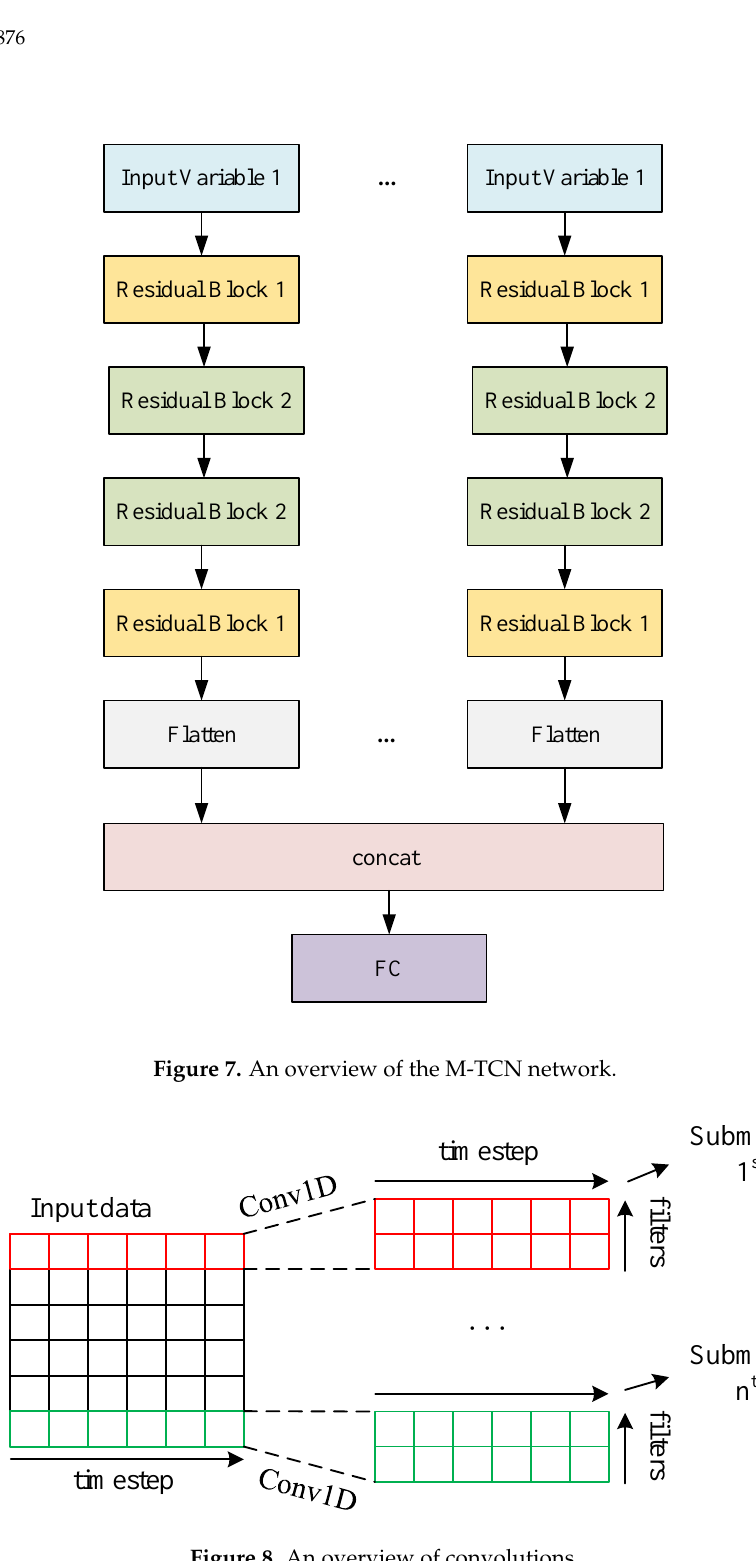
Figure 8. An overview of